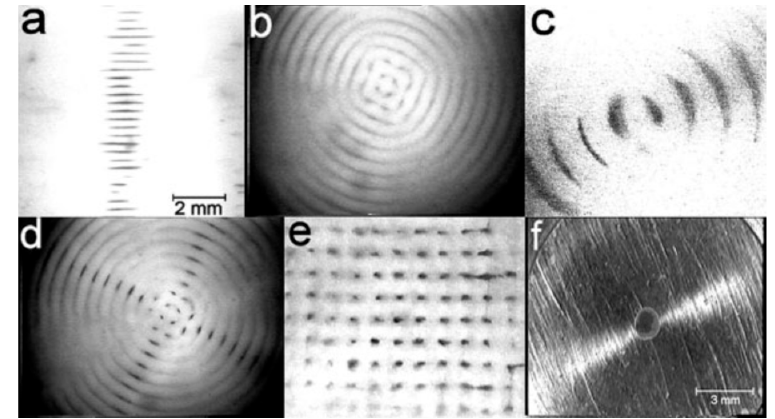
Figure 4. Cell aggregation under ultrasound standing wave and view normal to sound propagation ( a ) column of discoid aggregates in a plane cylindrical resonator; ( b ) initial pattern in tubular resonator-concentric cylinders; ( c ) aggregates of different sizes in a tubular resonator; ( d ) in plane and tubular resonator; ( e ) in a pair of two transducers perpendicular to each other; and ( f ) view in the direction of sound propagation of 3D RBC aggregate in the center of half-wavelength resonator, courtesy of [71].